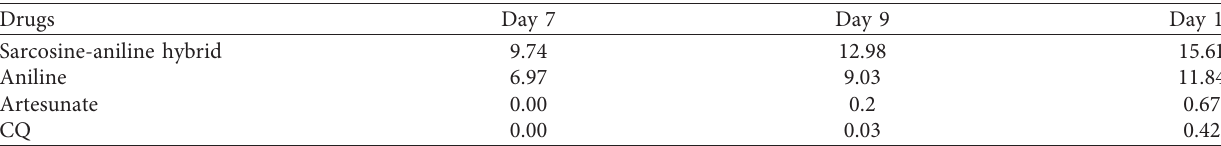
Table 3: Parasitaemia growth of sarcosine-aniline hybrid after stopping